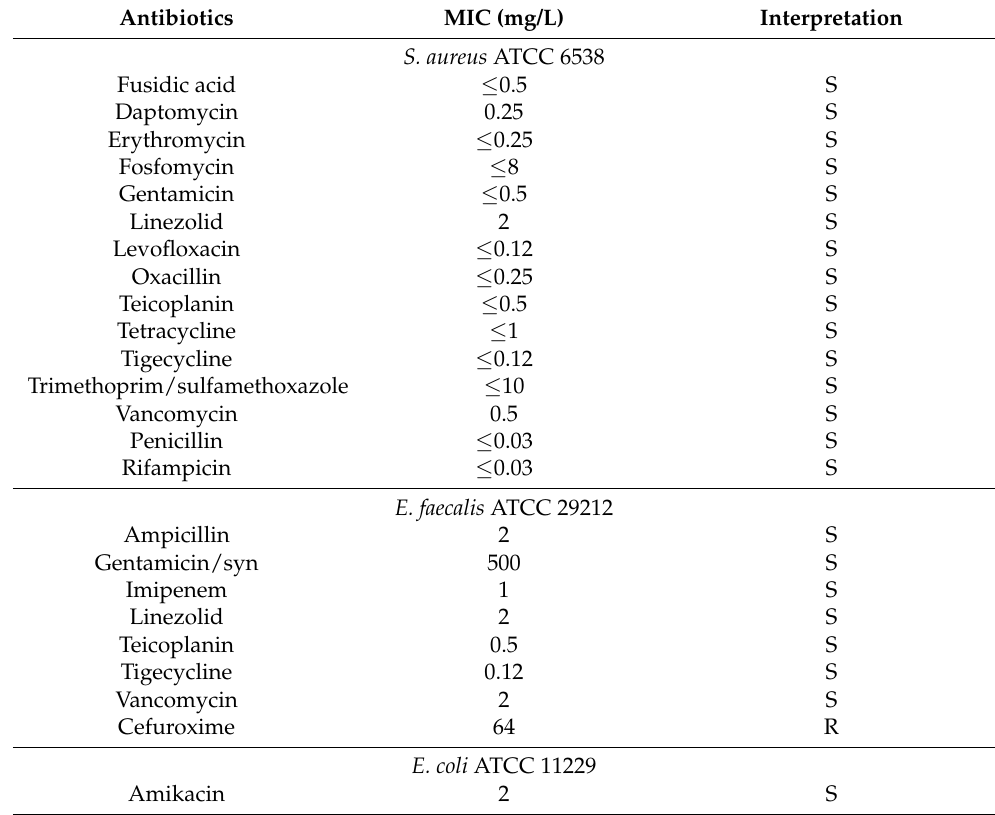
Table 1. Antibiotic resistance profiles of ATCC strains used in the study (S: susceptibility; R: resistant bacterial